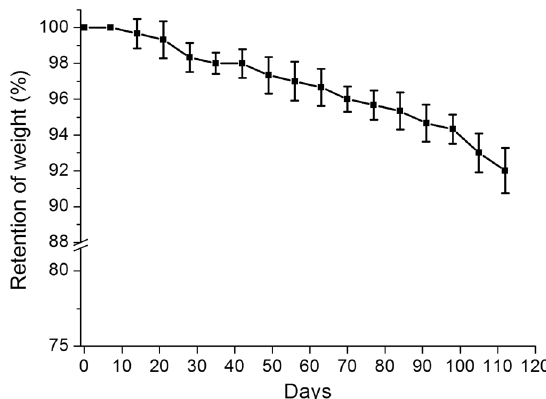
Figure 5. Weight change of the biodegradable stents with time (n = 5).